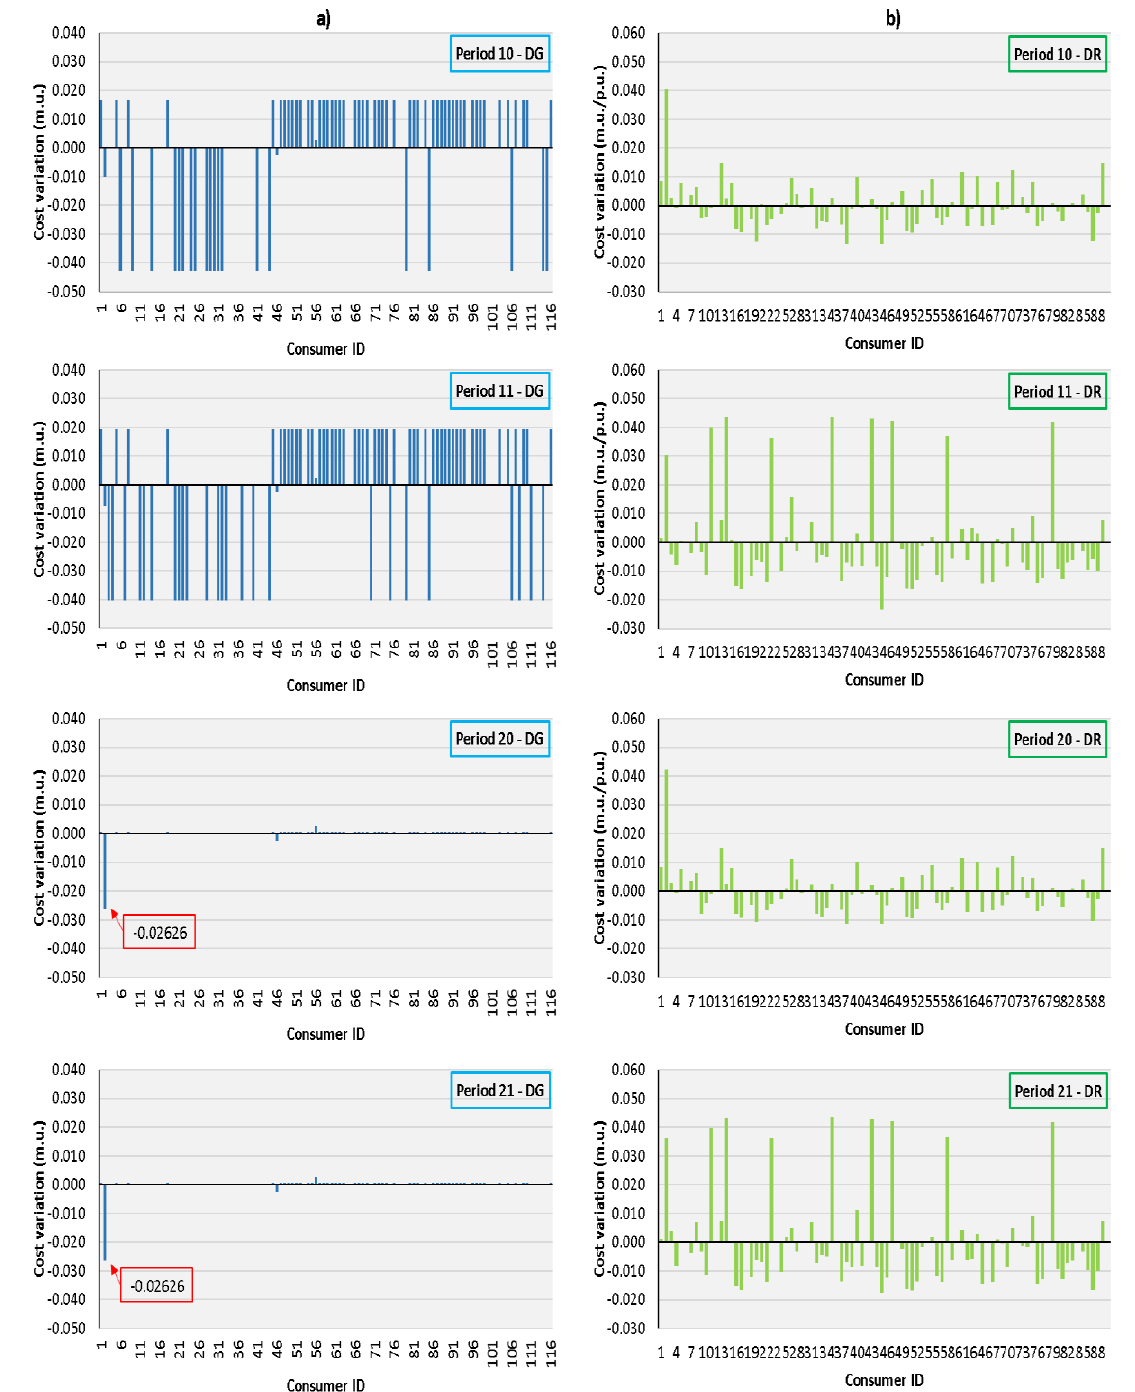
Figure 7. Changes in prices for ( a ) Distributed Generators and ( b ) Demand Response.